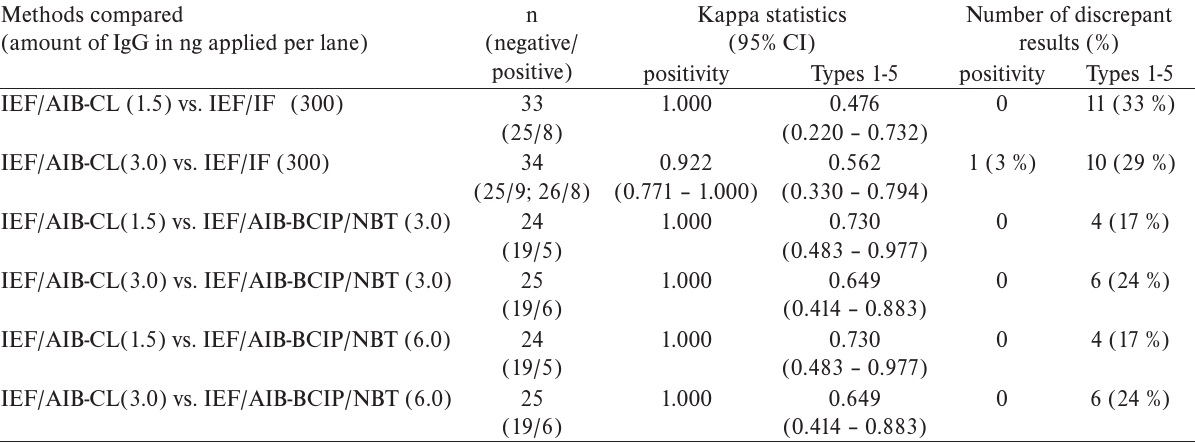
Table 1. Agreement between methods used for o-IgG detection evaluated by a blinded observer (PK). Methods